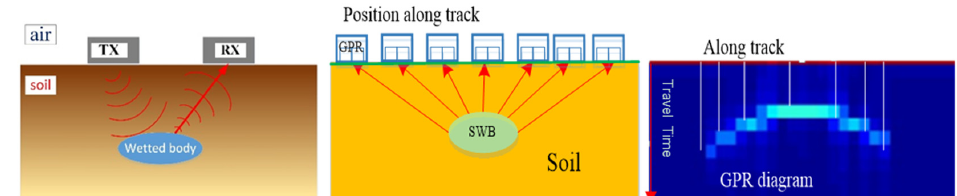
Figure 1. GPR detection principal mechanism of a SWB and the radargram. TX, transmitting antenna; RX, receiving antenna; Arrows, reflection of the SWB.